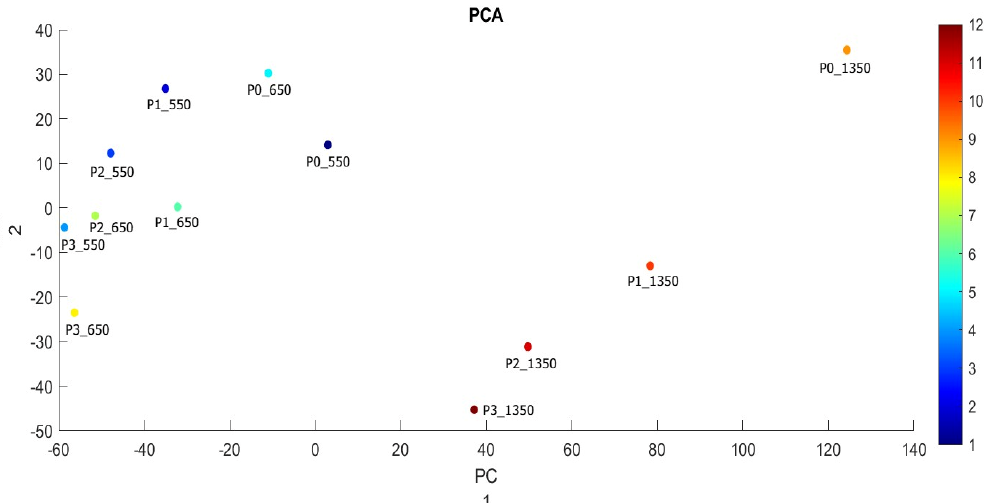
Figure 7. Graph of the distribution of bread samples in relation to the quality characteristics and the proportion of added hemp seed oil